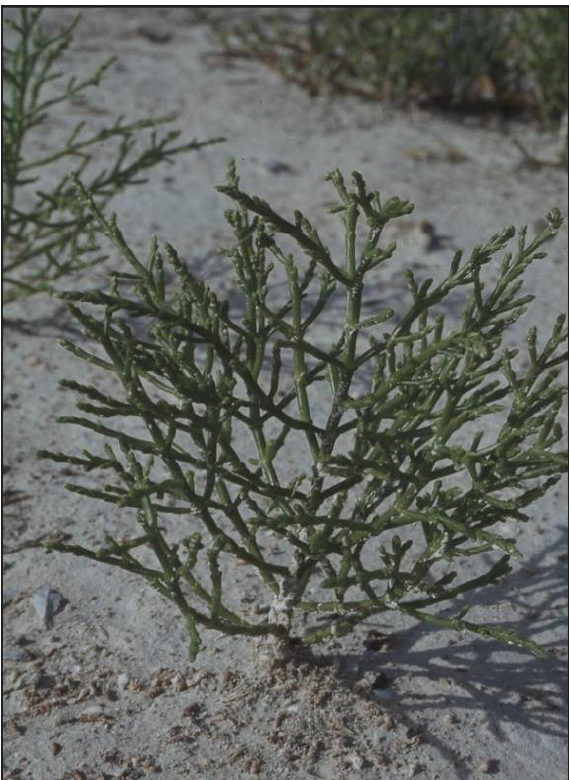
Figure 1. Photograph of Salicornia bigelovii in its natural habitat (Windsor Lake, CO, USA). By using seawater for irrigation, S. bigelovii has the enormous potential for being ex-